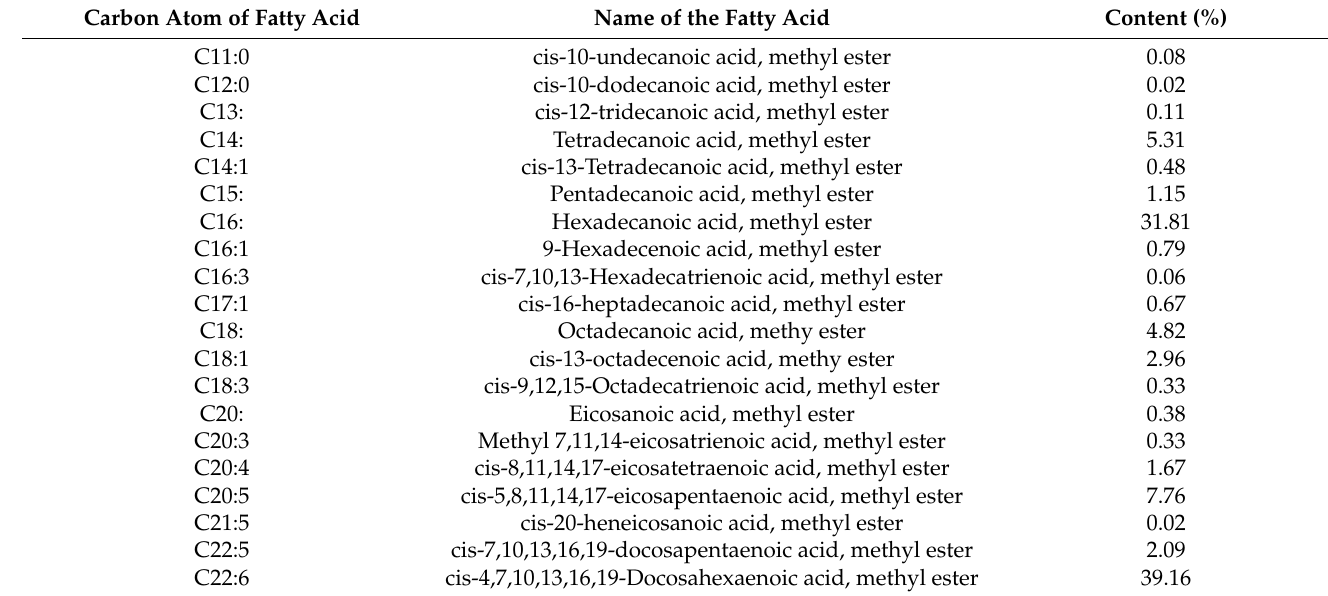
Table 5. Fatty acid composition (expressed as % of the total fatty acids) of Thraustochytrium kinnei . Carbon Atom of Fatty Acid Name of the Fatty Acid Content